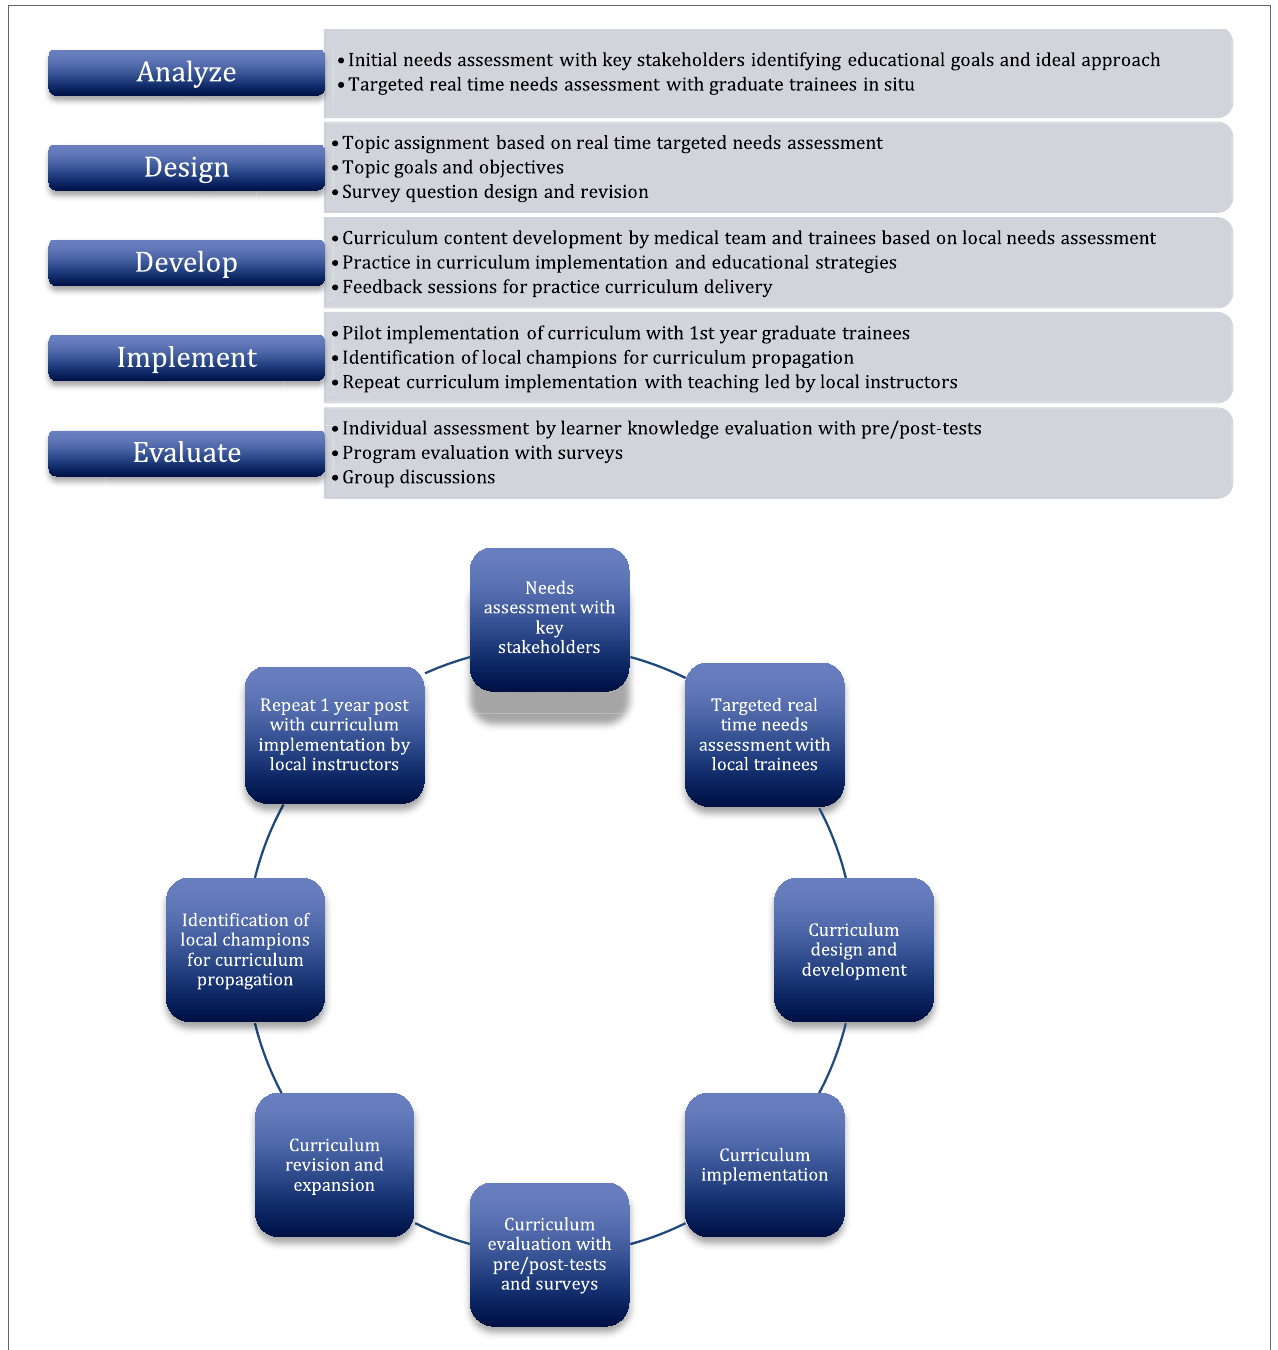
Figure 1 | addie model and project design